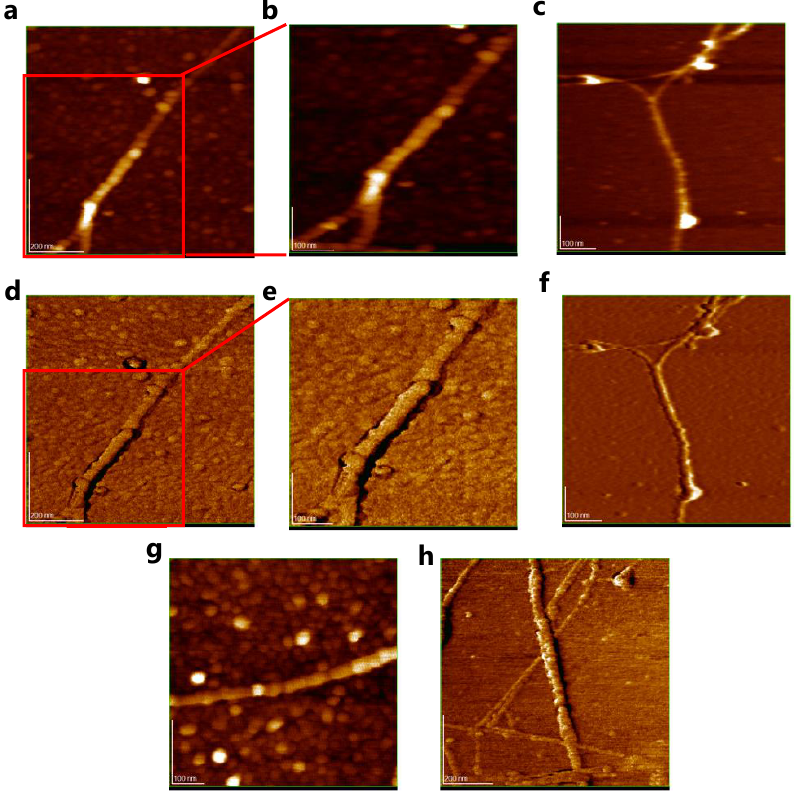
Figure 6. Typical AFM images ( a , b , c , g ) (topographic) and ( d , e , f , h ) (phase) of porphyrin poly- mer/AuNPs/SWNT nanohybrid on mica surface collected under ambient conditions. Although porphyrin polymer molecules form a well-ordered regular pattern, it is not fully clear (from AFM images) to judge whether it is a coplanar well-ordered regular re- peated array between neighboring molecules (Figure 7a) or the polymer molecules are wrapping along the tube surface, forming a helical structure (Figure 7b). As mentioned previously, we have tried to identify the supramolecular structures of porphyrin poly- mers on SWNT surfaces using STM imaging techniques, but unfortunately, we could not. Therefore, we decided to use HR-TEM measurements instead.